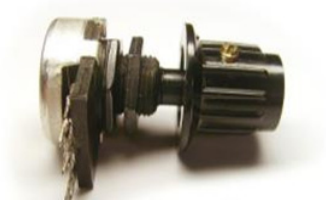
Figure 1. A potentiometer with a generic push-on